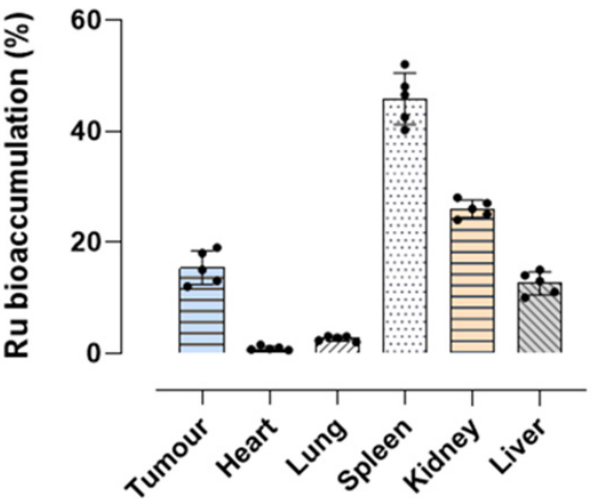
Figure 10. Ruthenium bioaccumulation in mice after HoThyRu/DOTAP regimen in vivo. Percentage of ruthenium amounts revealed by ICP-MS analyses and plotted in bar graph for the indicated body districts (heart, lung, spleen, kidney, and liver), including tumour lesions, at the endpoint (4 weeks) of the preclinical study. After weekly administrations of HoThyRu/DOTAP (15 mg/kg, i.p., once a week for 4 weeks), the mice were sacrificed, and organs and tissues were appropriately collected to analyze the ruthenium content ( n = 5 animals).